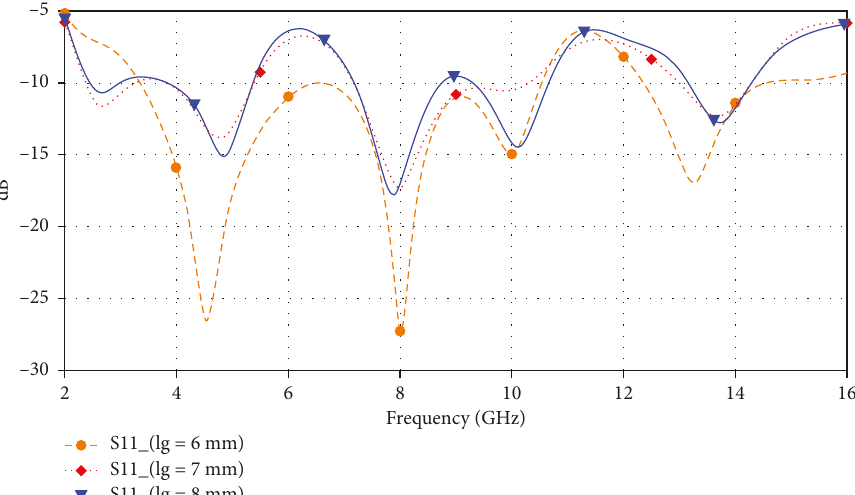
Figure 7: Parametric analysis-ground length lg.